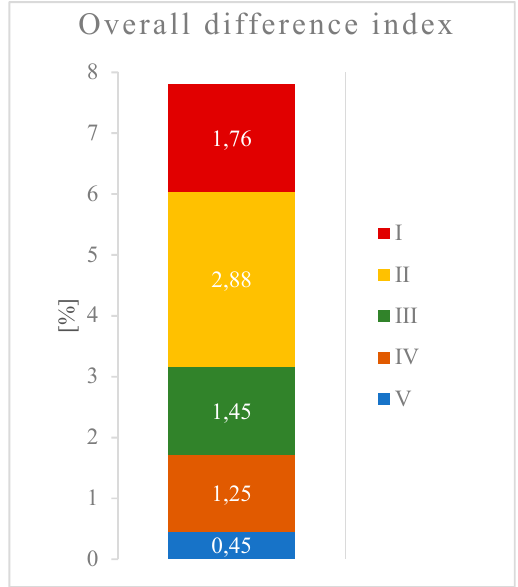
Figure 3. The average values of the difference index (DI) in 2006.